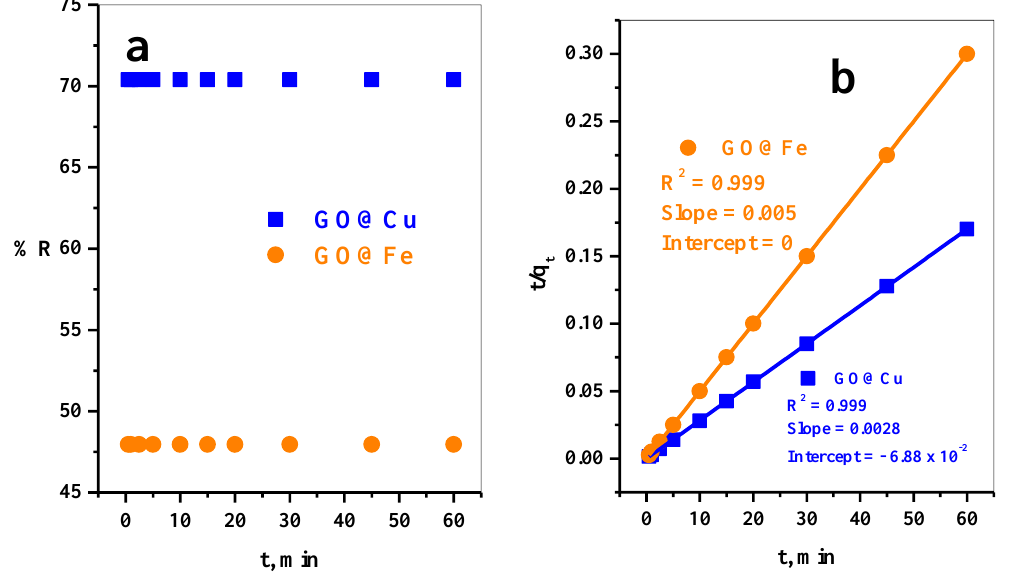
Figure 5. Effect of ( a ) contact time on removal percent, ( b ) Pseudo second-order plot of MB-dye adsorption using GO@Cu ([MB] = 50 mg L − 1 , Dose = 5 mg, V = 50 mL, pH = 7, T = 25 °C) and GO@Fe ([MB] = 50 mg L − 1 , Dose = 6 mg, V = 50 mL, pH = 7, T = 25 °C) from aqueous media.